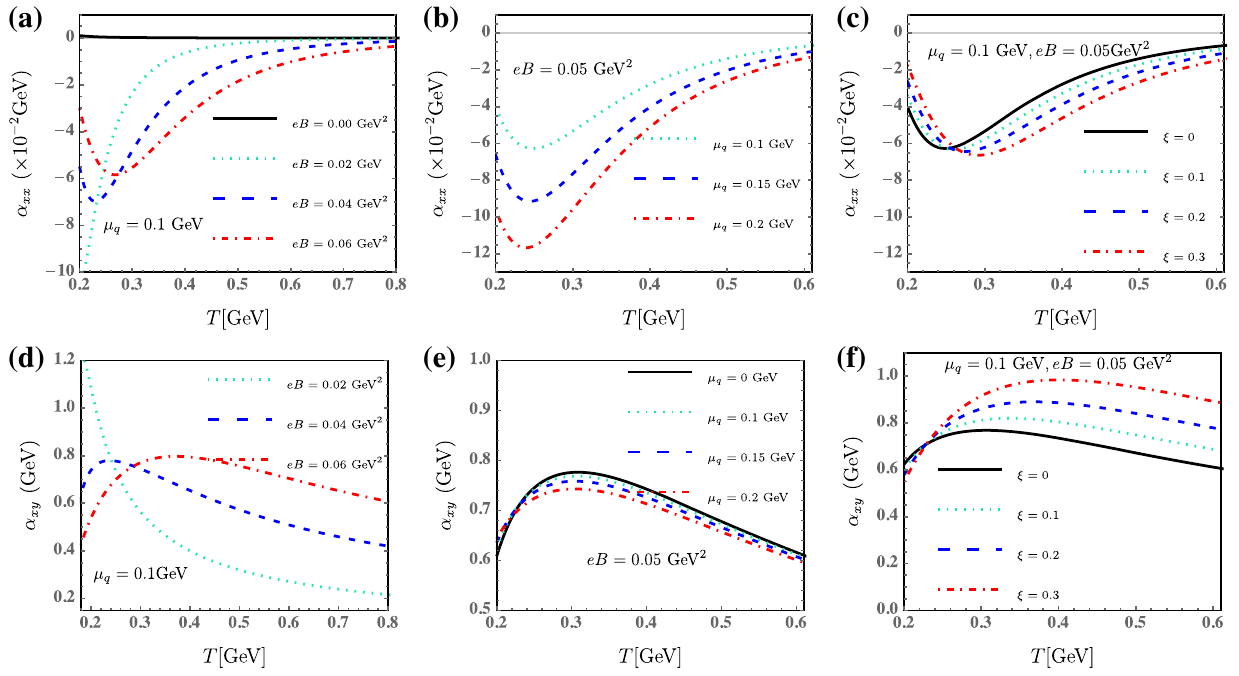
Fig. 3 a , d The temperature dependences of the thermoelectric con- ductivity ( α xx ) and the Hall-like thermoelectric conductivity ( α xy ) for μ = 0 . 1GeVatdifferentmagneticfields,namely, eB = 0GeV 2 (black q solid line), 0.02 GeV 2 (cyan dotted lines), 0.04 GeV 2 (blue dashed lines),0.06GeV 2 (reddotted-dashedlines). b , e Thetemperaturedepen- dences of α xx and α xy for eB = 0 . 05 GeV 2 at μ q = 0 GeV (black solid